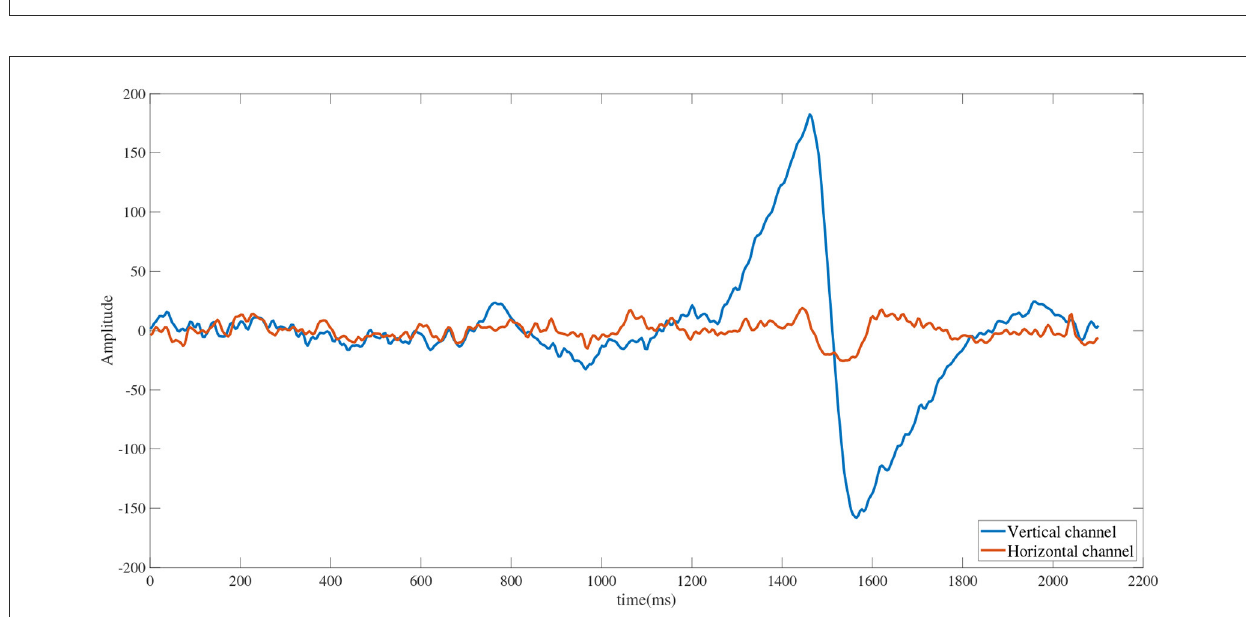
FIGURE4 Waveforms of horizontal and vertical channels during eye movements (left). Blue line indicates horizontal channels and orange line indicates horizontal channels.